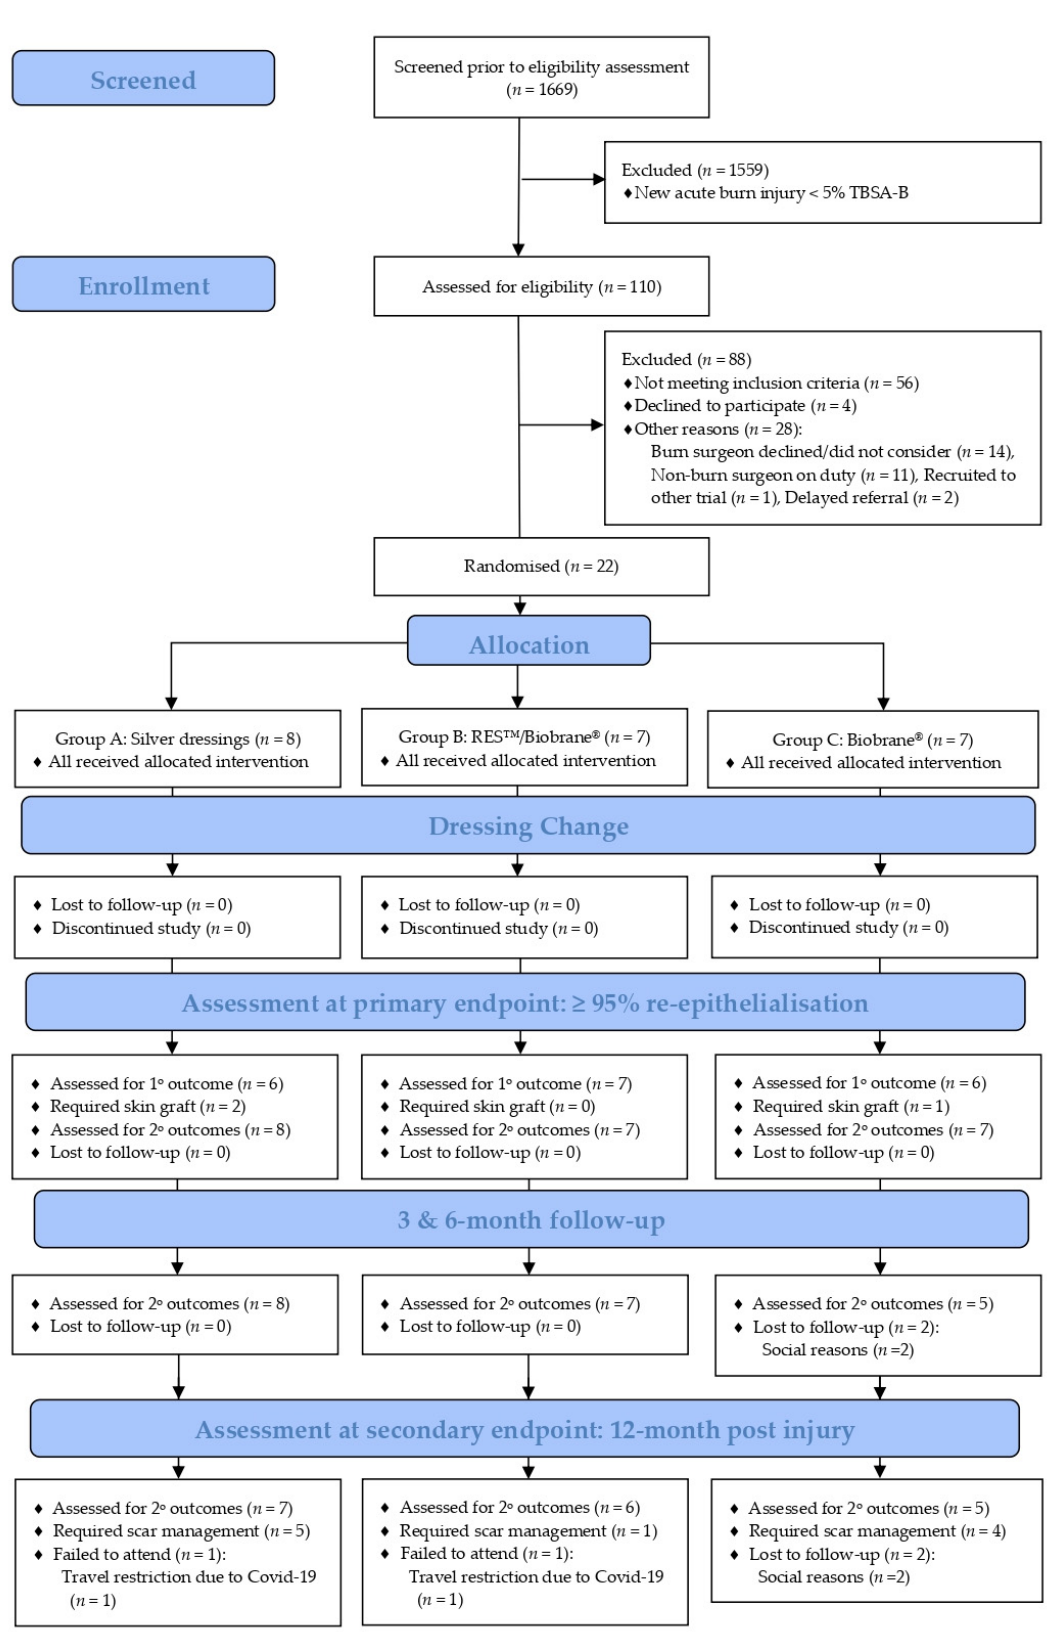
Figure 1. BRACS Trial CONSORT flow diagram. RES™: Regenerative Epidermal Suspension; TBSA ‐ B: total body surface area burned; 1°: primary; and 2°: secondary.